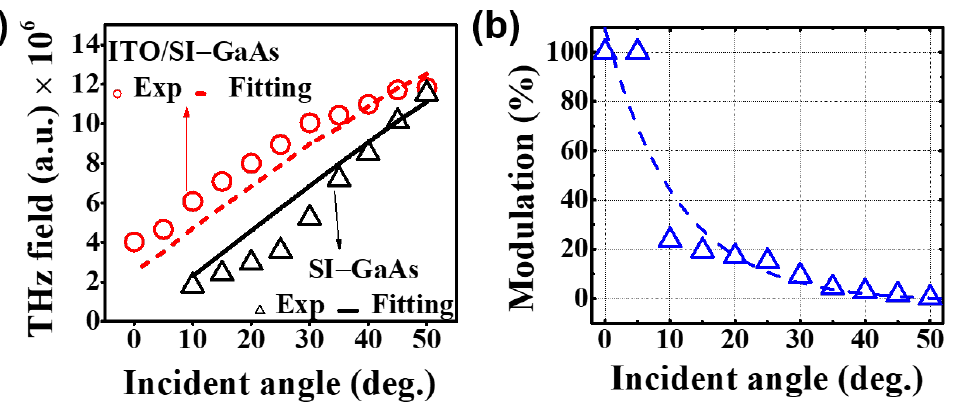
Figure 7. Optical pump incident angle dependence. ( a ) THz emission from SI-GaAs and ITO/SI − GaAs and ( b ) enhancement modulation with ITO/SI − GaAs sample.